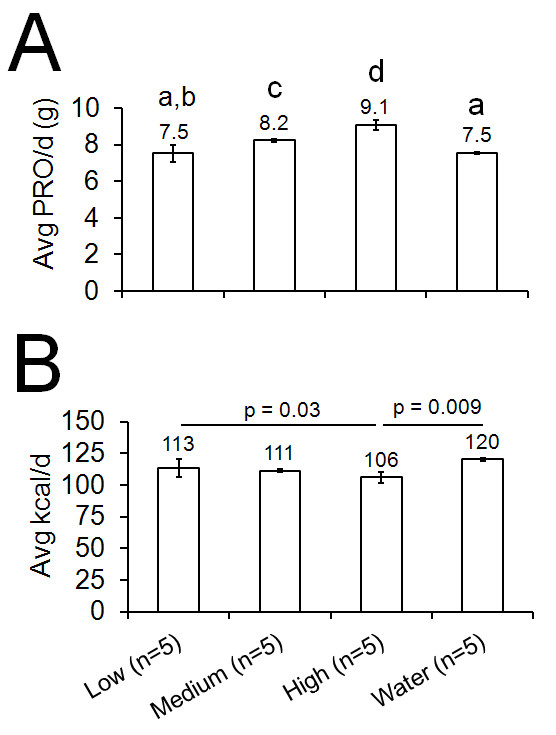
Average daily protein (‘PRO/d’, A) and kilocalorie (‘kcal/d’, B) intake over the 30-day daily gavage feeding of 1 human equivalent dose (1.1 g/d, ‘low’), 3 human equivalent doses (3.4 g/d, ‘medium’), and 6 human equivalent doses (6.8 g/d, ‘high’) of the WPH-based supplement as well as water only (‘water’). All data are presented as mean ± SE and daily averages are presented numerically above each bar. As expected, average protein intakes over the 30-day intervention (subfigure A) were as follows: high > medium > low = water (p < 0.01 denoted by different letters above each bar). Interestingly, energy intakes were significantly lower in the high condition relative to the low and water conditions (p-values presented above bars).